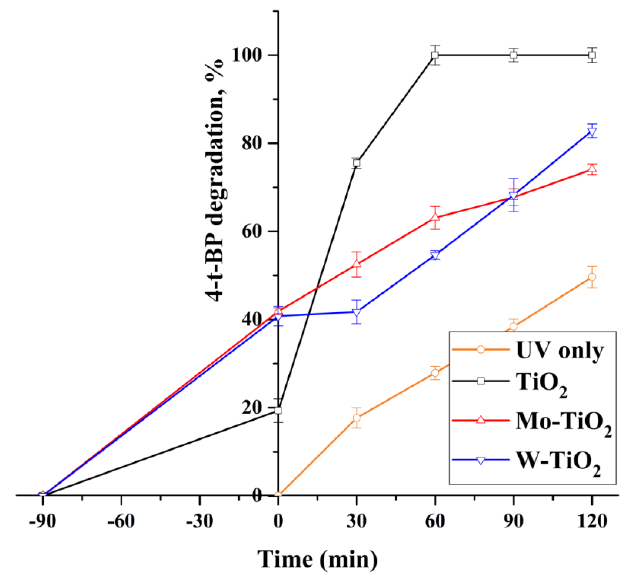
Figure 20. The photocatalytic activity of TiO 2 , Mo ‐ TiO 2 , and W ‐ TiO 2 under UV irradiation.